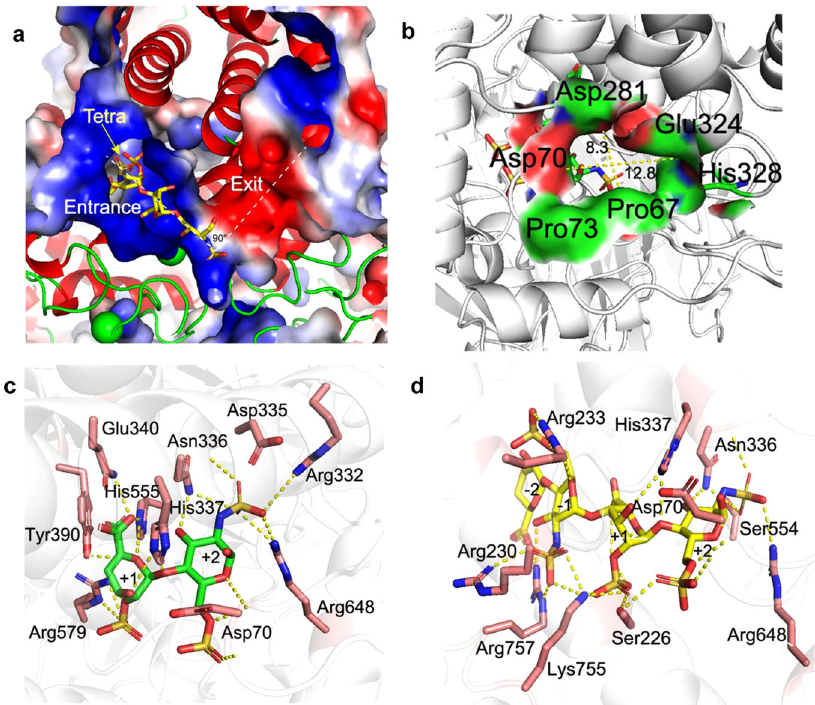
Fig. 4 The L-shaped catalytic tunnel and relative sites of BIexoHep. Sectional view of the L-shaped tunnel with a tetrasaccharide substrate. a The positively charged entrance (blue) and negatively charged exit (red) of the tunnel are indicated with white dashed lines, and the tetrasaccharide substrate is denoted by a yellow arrow. b Key residues in the negatively charged exit. The residues are shown in surface representation. Binding of an HP disaccharide product to the positively charged entrance of BIexoHep. c The disaccharide ( Δ UA2S1-4GlcNS6S) is shown in thick lines and its carbon atoms are colored green, and the side chains of surrounding residues are shown in thick lines and their carbon atoms are colored fuchsia. d Binding of an HP tetrasaccharide substrate to the positively charged entrance of BIexoHep-Y390A/H555A. The tetrasaccharide ( Δ UA1-4GlcNS6S1-4IdoA2S1-4GlcNS6S) and surrounding residue side chains are shown as yellow sticks and as fuchsia sticks, respectively. Hydrogen bonds are shown as dashed